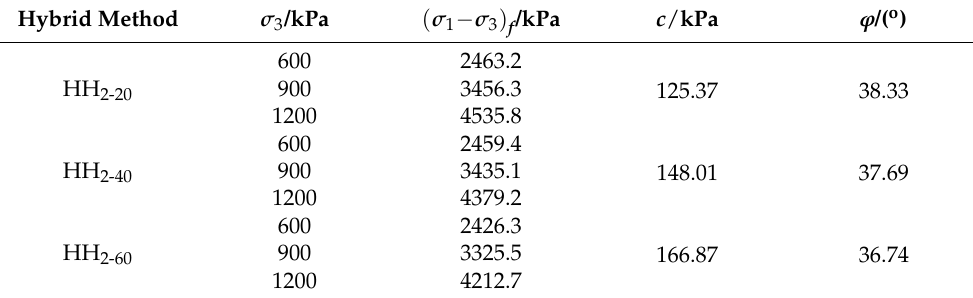
Table 3. Strength index of different size